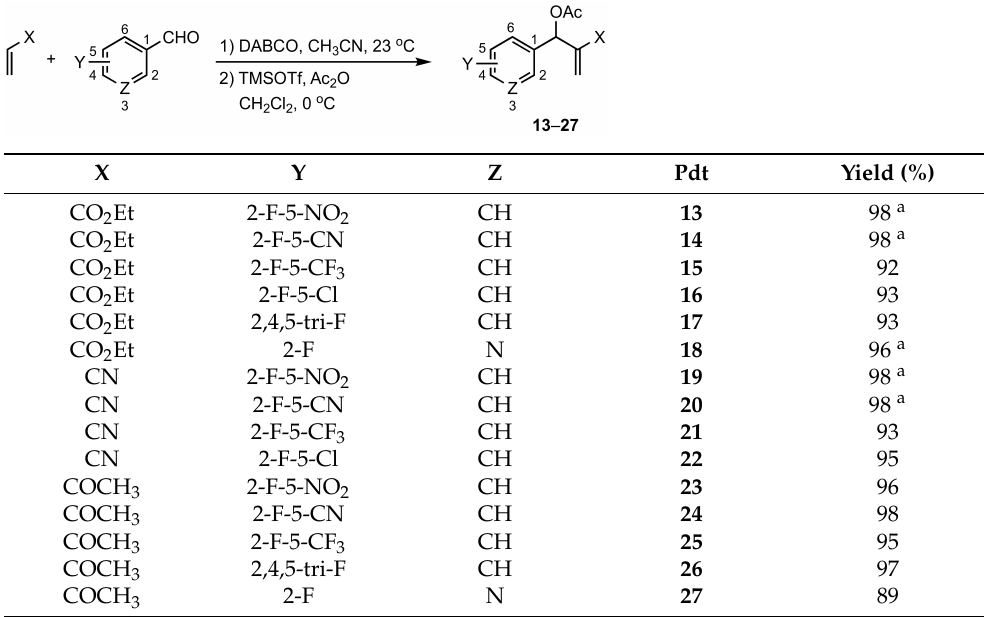
Table 1. Synthesis of MBH